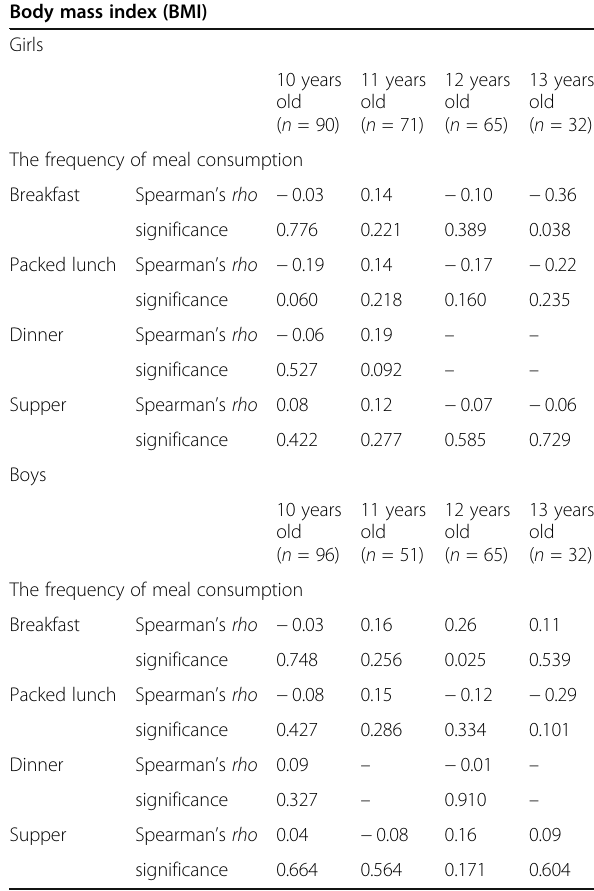
Table 7 The correlation between BMI and the frequency of meal consumption depending on age and